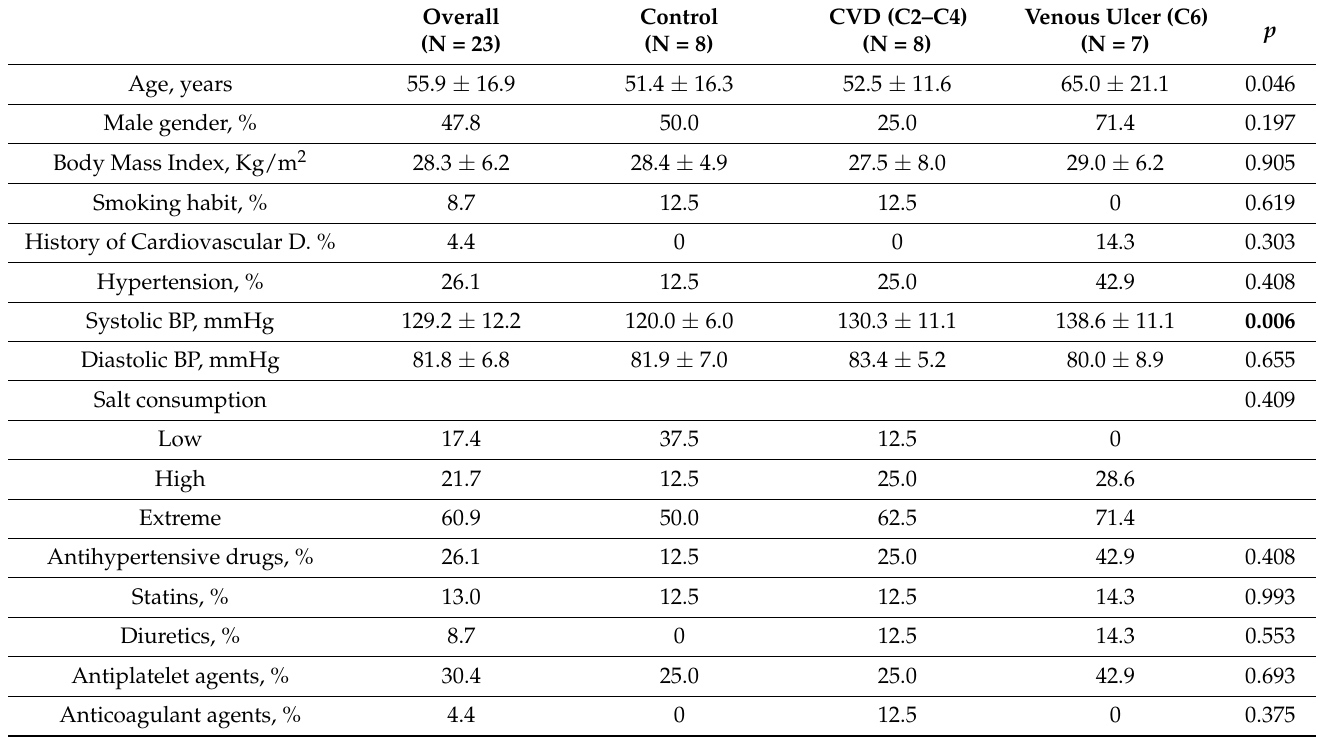
Table 1. Baseline characteristics of overall patients and for the categories of venous